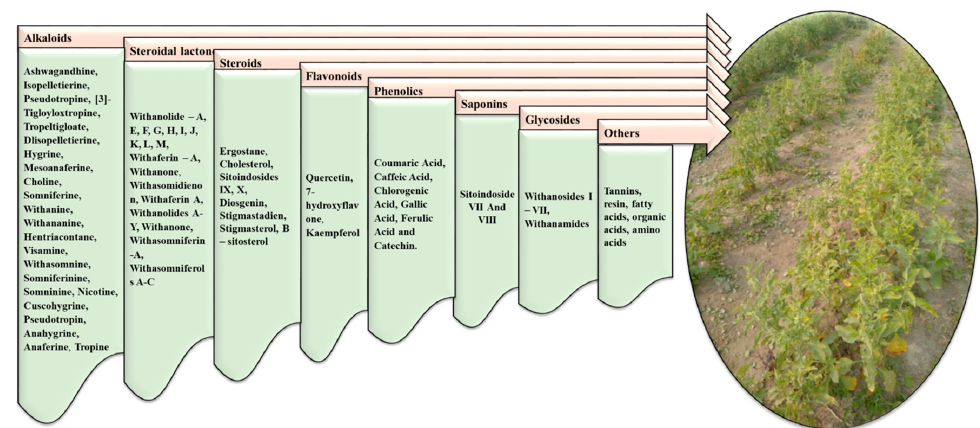
Figure 2. Various classes of bioactive compounds present in Withania somnifera